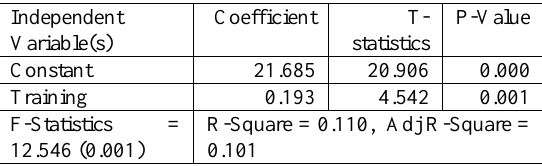
Table 2: Regression Results (Dependent Variable -